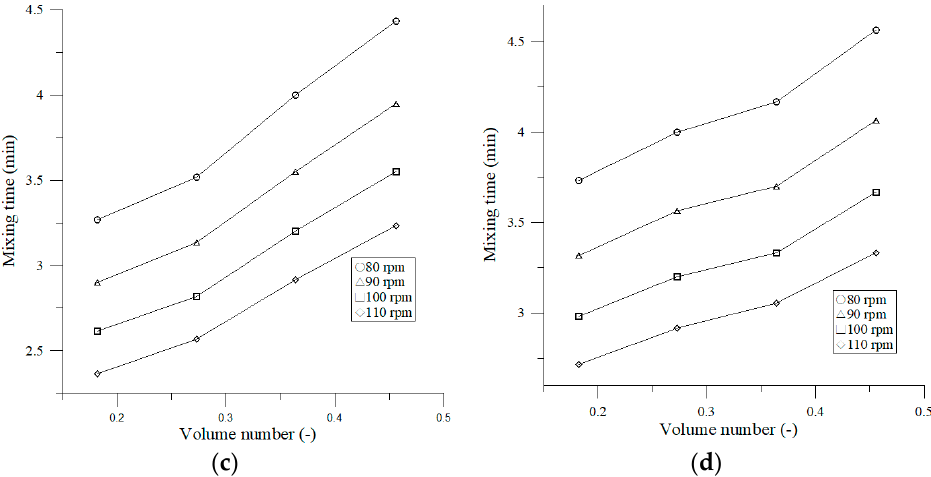
Figure 9. Relationship between mixing number and volume number of different shaking frequencies.